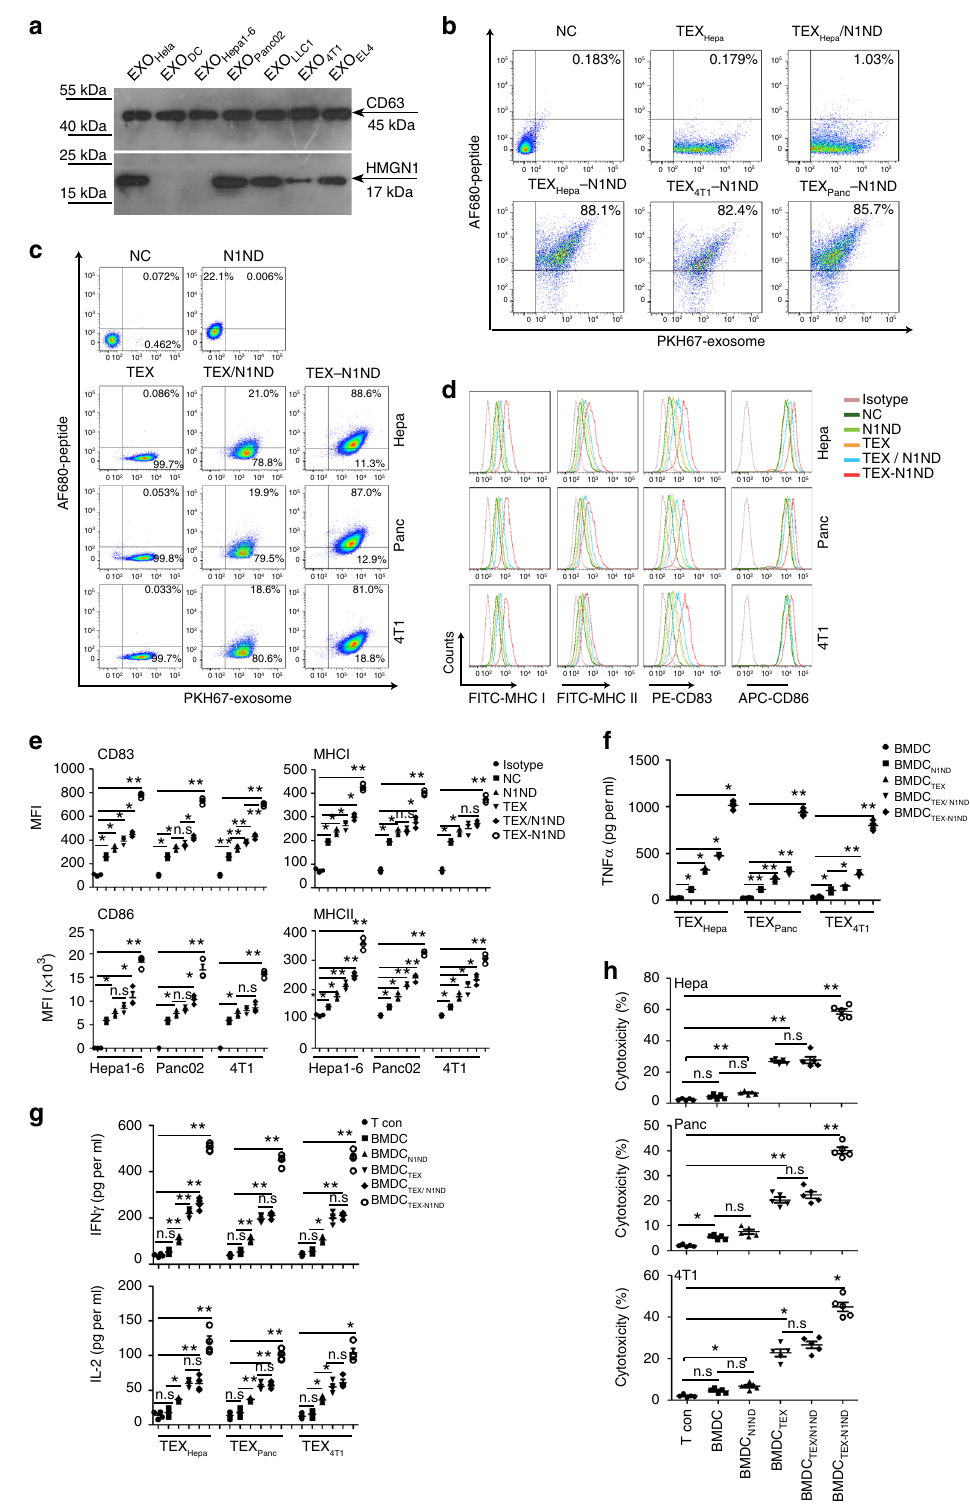
contrast, no signi fi cant change was found for B cells across dif- ferent treatment groups (Fig. 2b, c). Similarly, durable tumor retardation was observed for Panc02 and 4T1 subcutaneous tumor-bearing mice treated with BMDC TEX-N1ND compared with other groups on day 42 (Fig. 2d, e) with similar shifts in circu- latory and tumor CD8 + T cells and Tregs (Fig. 2f, g), suggesting that the strategy is broadly applicable across tumor